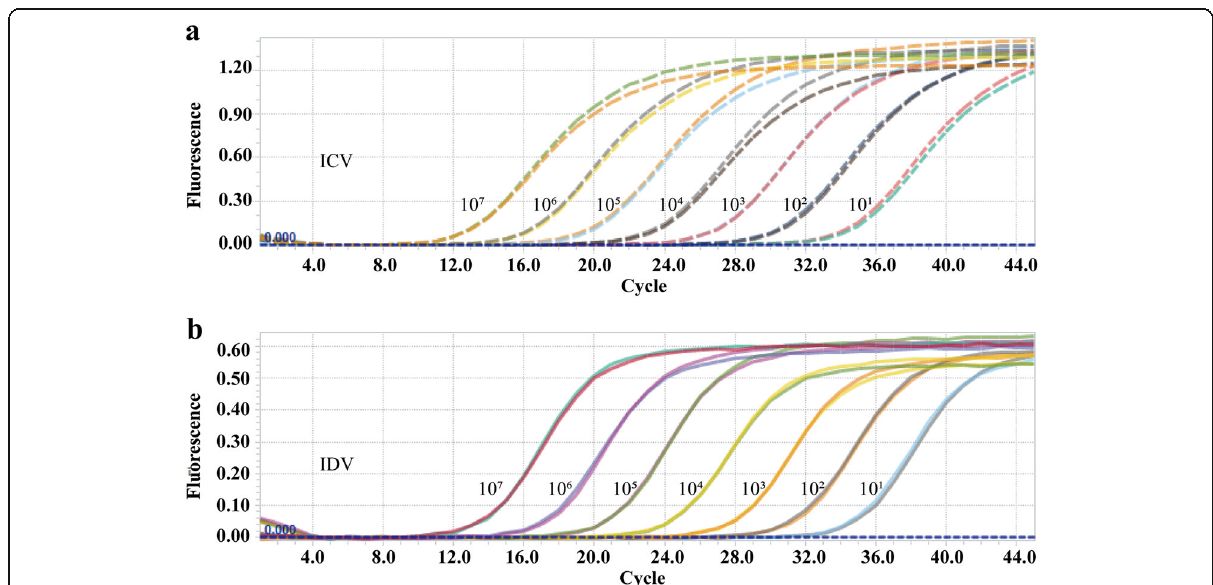
Fig. 2 Sensitivity of duplex real-time PCR assay. a , b Amplification curvesof plasmid standards of ICV and IDV at concentrations ranging from 1 × 10 7 copies/ μ L to 1 × 10 1 copies/ μ L detected by duplex real-time PCR